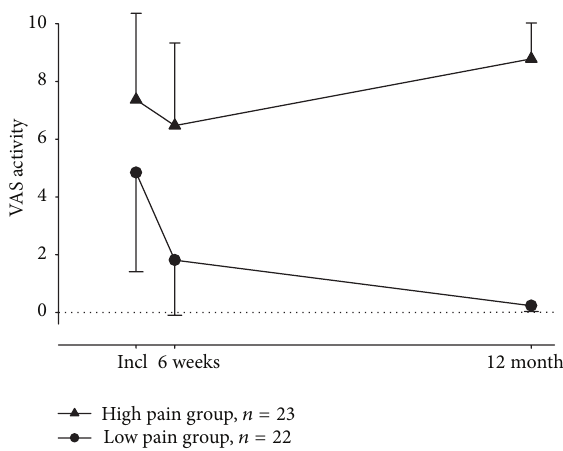
Figure 1: Intensity of pain in 45 disc herniation patients recruited from Oslo University Hospital, Ullev˚al, Norway. The patients were divided into two groups based on their clinical outcome measured by VAS at 12-month follow-up. The data are shown as mean ±